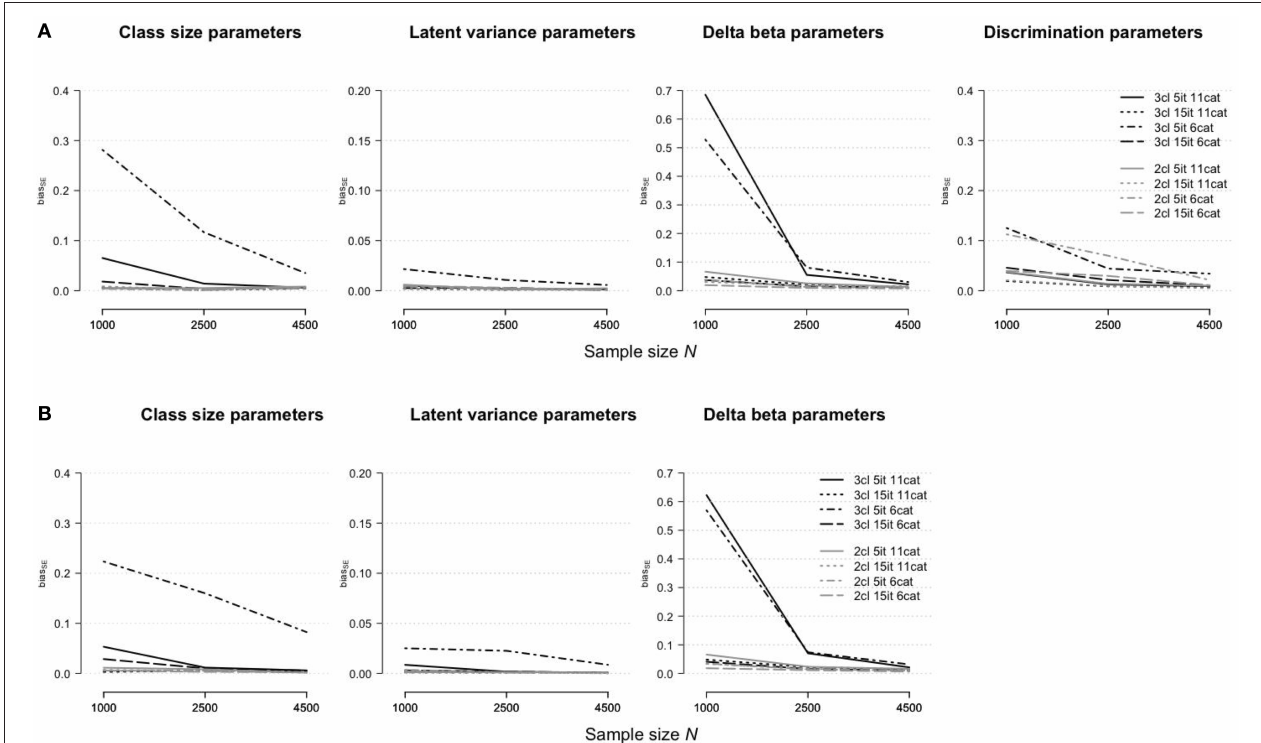
FIGURE 5 | Bias of standard error estimates for parameter estimates in (A) the rmGPCM-3 and (B) the mPCM-3 under further data